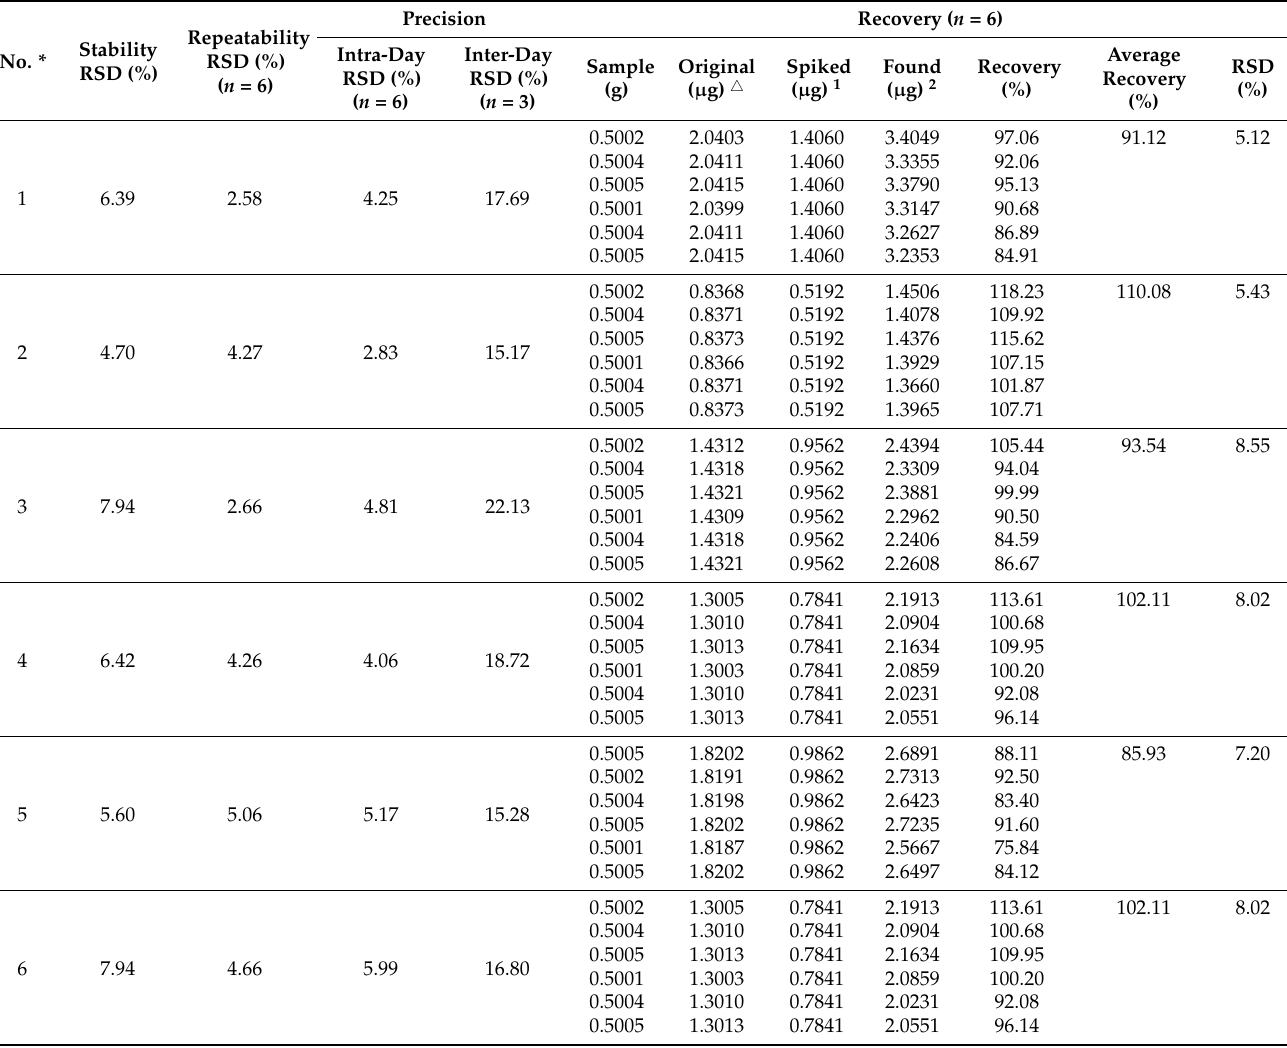
Table 1. The stability, repeatability, precision, and recovery of 6 compounds in the detection of free